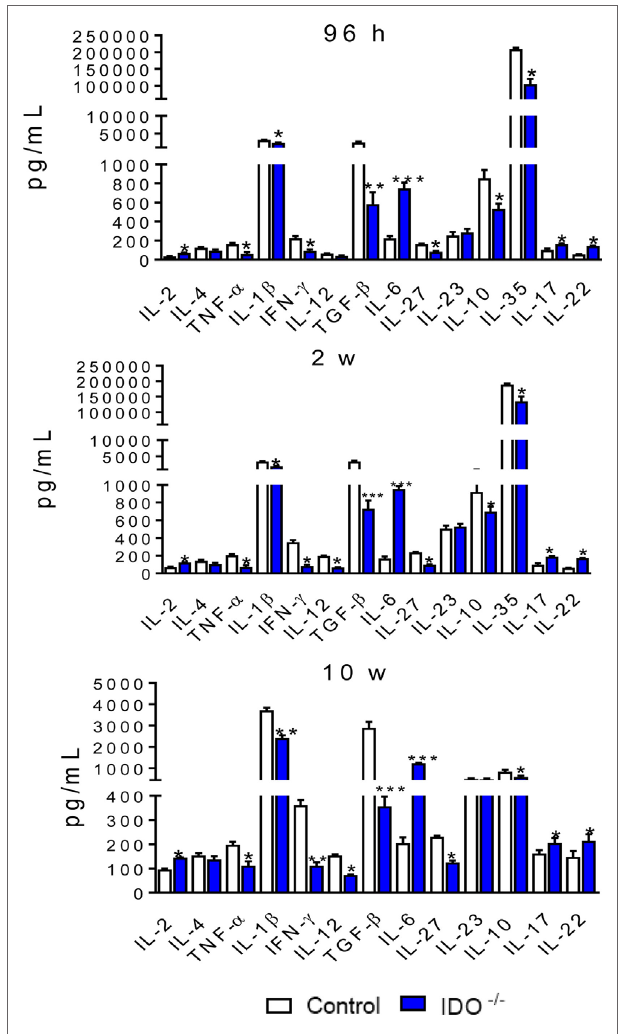
FigUre 7 | Indoleamine 2,3 dioxygenase-1 (IDO1) regulates the levels of pulmonary cytokines. Quantitation of cytokines in lung homogenates of wild-type and IDO1 − / − mice infected with 1 × 10 6 viable Paracoccidioides brasiliensis yeasts . The levels of cytokines were measured by enzyme-linked immunosorbent assay in lung homogenates obtained at 96 h, 2, and 10 weeks of infection. Bars show mean ± SEM from at least four mice per group and are representative of two independent experiments (* p < 0.05, ** p < 0.01, and *** p <